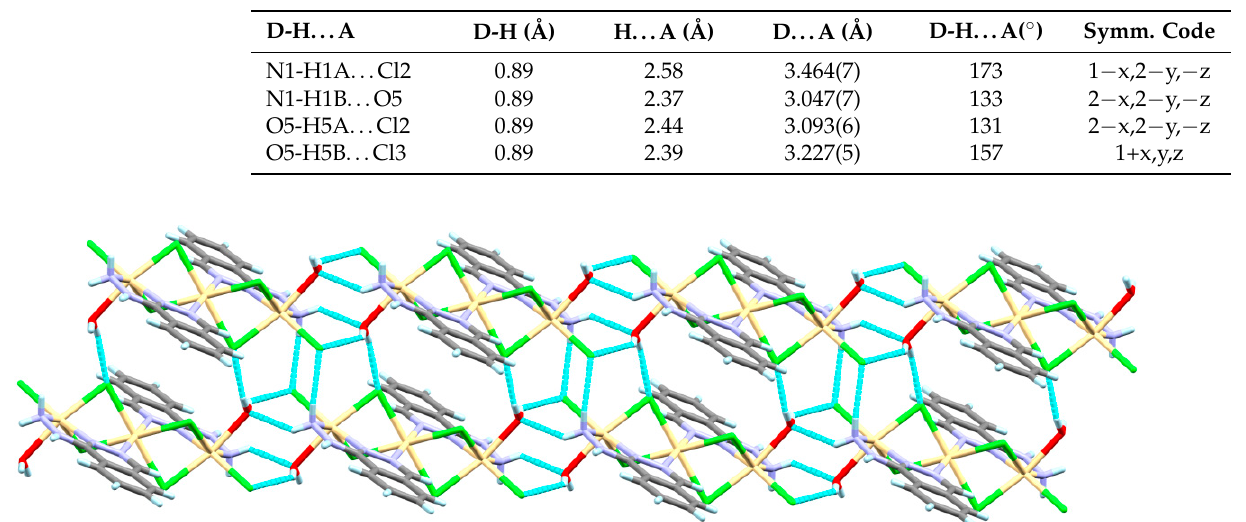
Table 7. The hydrogen bond parameters in 3 .